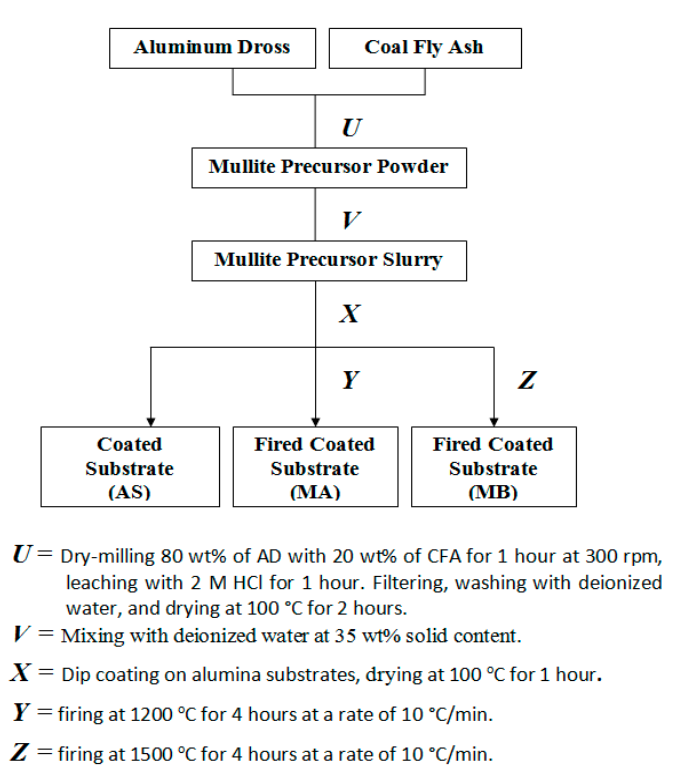
Figure 1. The preparation of mullite washcoat on alumina substrates .